Question: State the chart type depicted above.
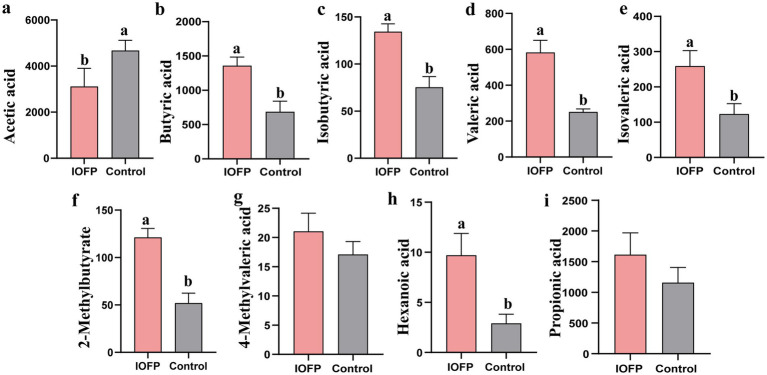
Answer: bar